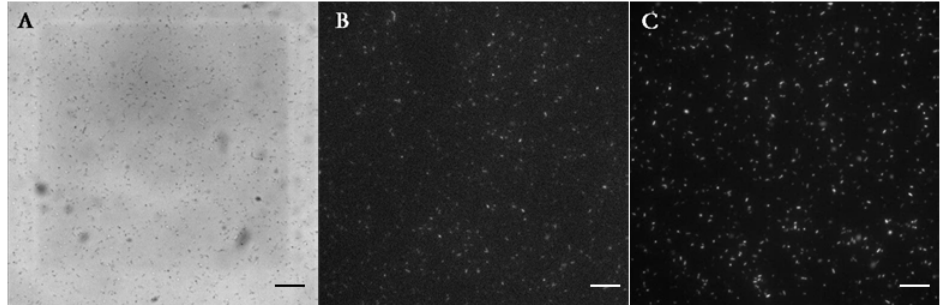
Figure 4. Quorum sensing of LasR E. coli in bulk aqueous phase. ( A ) The bright field image of LasR E. coli mixed with 1 nM OdDHL in bulk; ( B ) The green fluorescent image shows the expression of GFP in bacteria; ( C ) The red fluorescent image shows the same bacteria that expressed